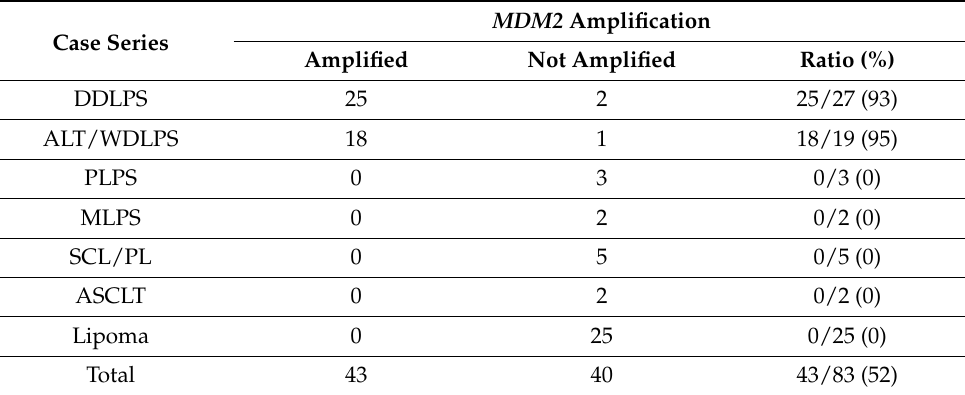
Table 1. LPS variants/other lipomatous tumors and corresponding MDM2 amplification